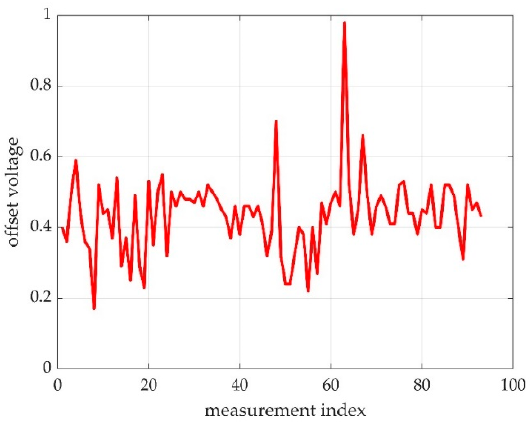
Figure 10. Detected offsets in a set of 93 measurements. About 4% are erroneous detection; for the point approaching 1V level, the error is obvious.